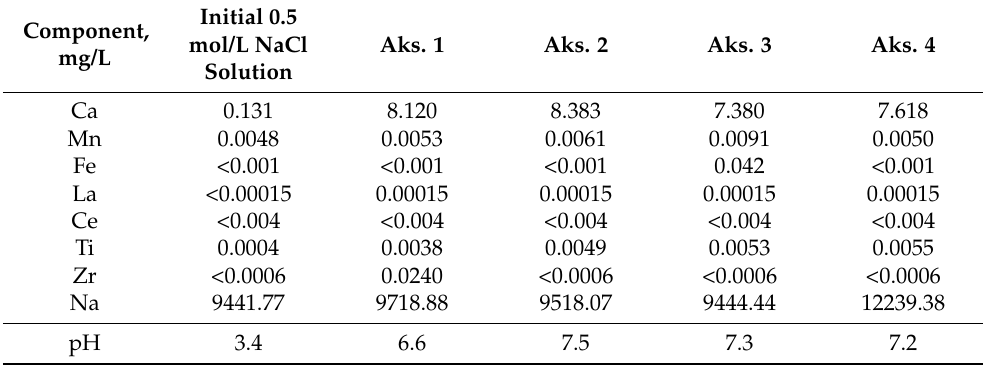
Table 7. Chemical composition (mg/L) and pH of both initial solution and solutions after experiments with 0.5 mol/L NaCl solution.